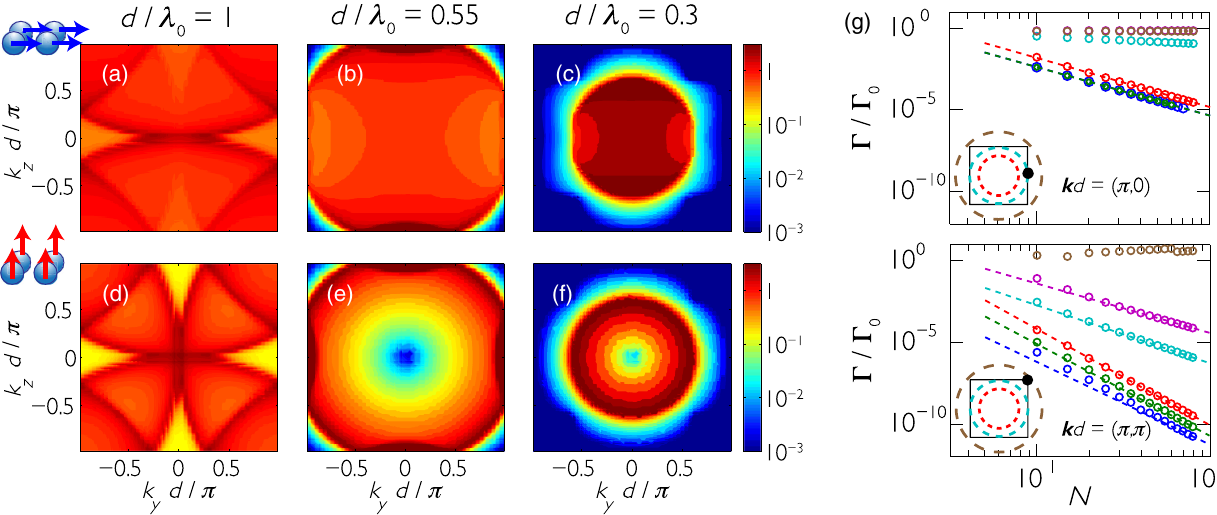
FIG. 5. Single-excitation collective modes in 2D square array of 50 × 50 two-level atoms. Collective decay rates as a function of predominant wave vector ( k , k ) associated with the mode, for different values of d= λ 0 : (a) – (c) are for parallel atomic polarization along y z ˆ y axis; (d) – (f) are for transverse polarization. Subradiant and guided modes arise outside the circle defined by the light line ( j k j ¼ k ffiffiffi p 2 d= λ 0 < 1 = . For d= λ 0 < 1 and transverse atomic polarization, a different class of subradiant states emerges at k ¼ ð 0 ; 0 Þ . (g) Scaling of decay rates with N ( N 2 being the number of atoms) for two particular modes ð k (bottom). Different colors are for different values of d= λ 0 ¼ 0 . 25 , 0.3, 0.4, 0.5, 0.6, 1 = respectively). The dashed lines are guides to the eye for N − 3 and N − 6